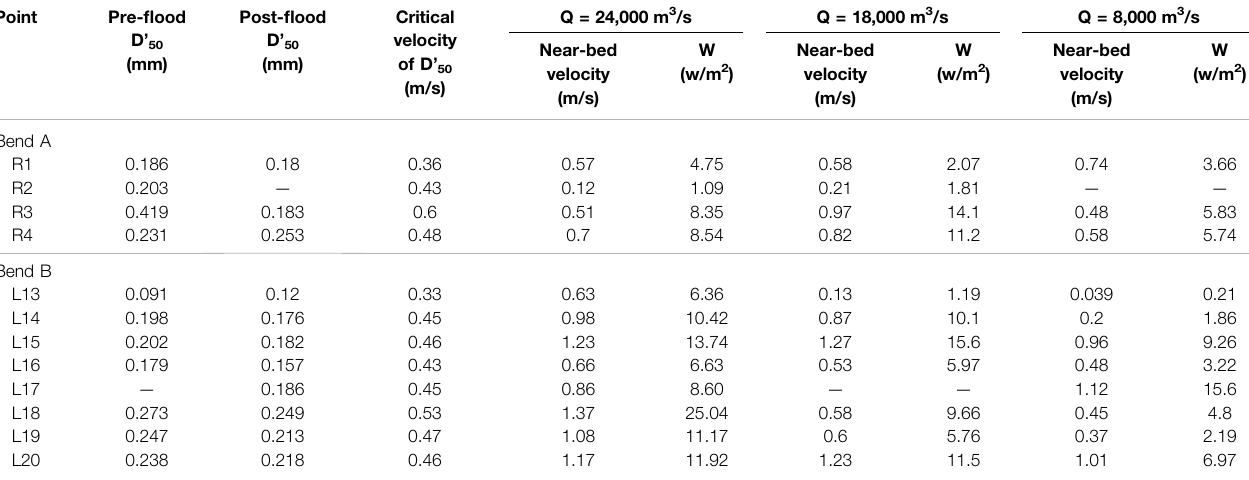
TABLE 4 | Comparison between critical velocity of bed material, near-bed velocity, and stream power at different fl ow discharges on the concave bank. Point Pre- fl ood D ’